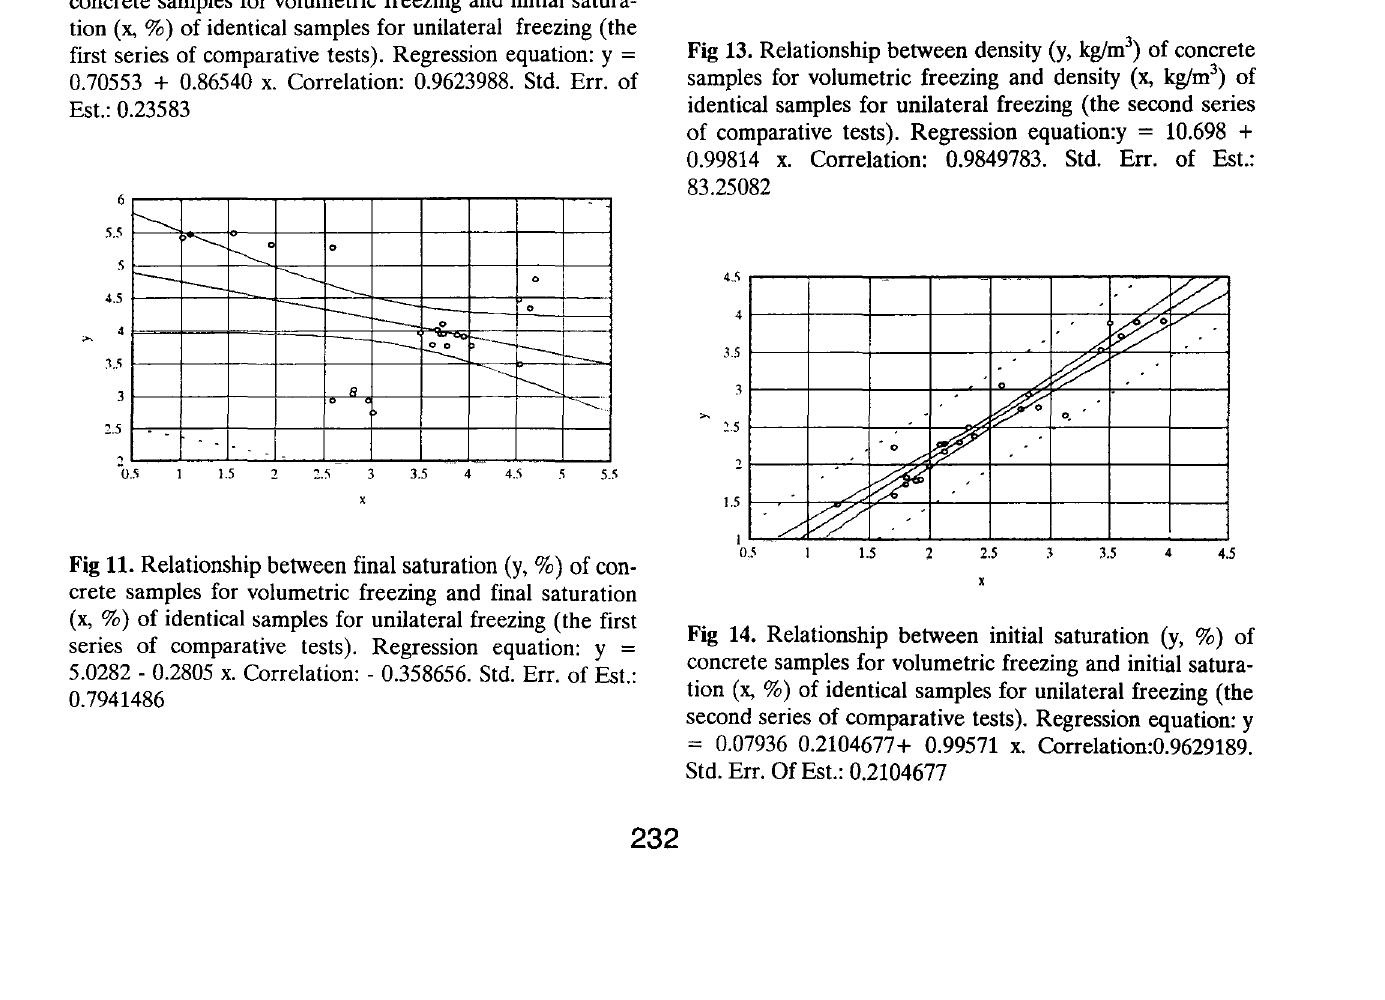
Fig 10. Relationship between initial saturation (y, %) of concrete samples for volumetric freezing and initial satura tion (x, %) of identical samples for unilateral freezing (the first series of comparative tests). Regression equation: y = 0.70553 + 0.86540 x. Correlation: 0.9623988. Std. Err. of Est.: 0.23583